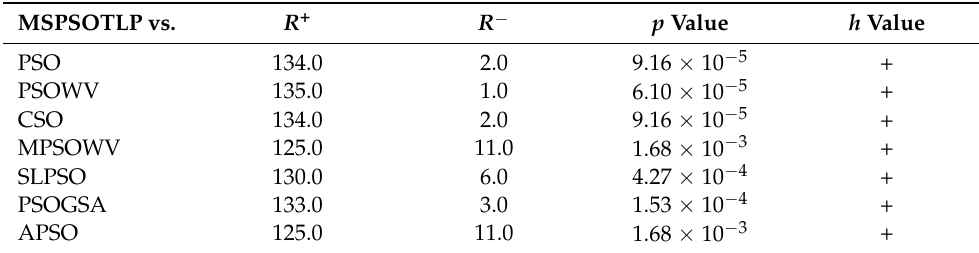
Table 14. Wilcoxon signed rank test as pairwise comparison between the ANN models optimized by MSPSOTLP and each PSO variant when classifying the testing samples. MSPSOTLP